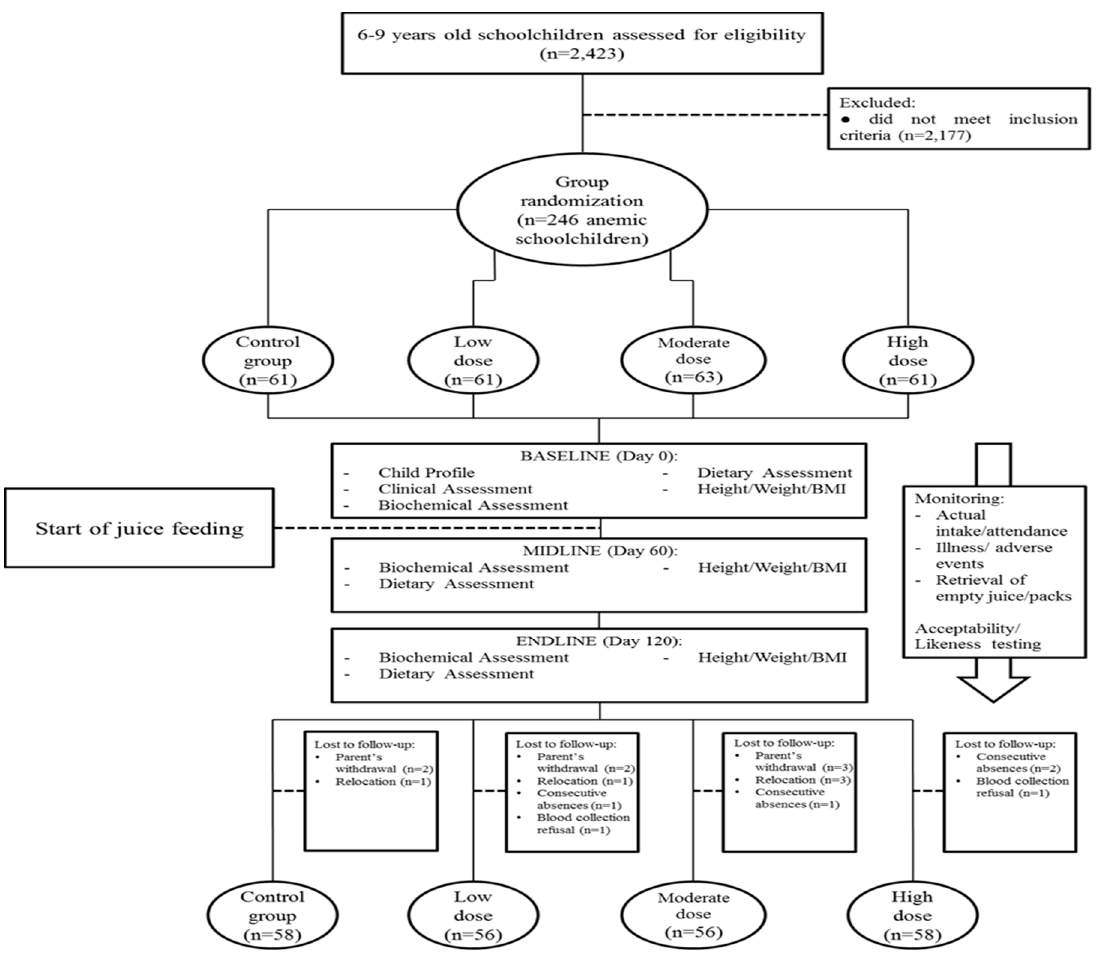
Figure 1. Consort flow diagram.